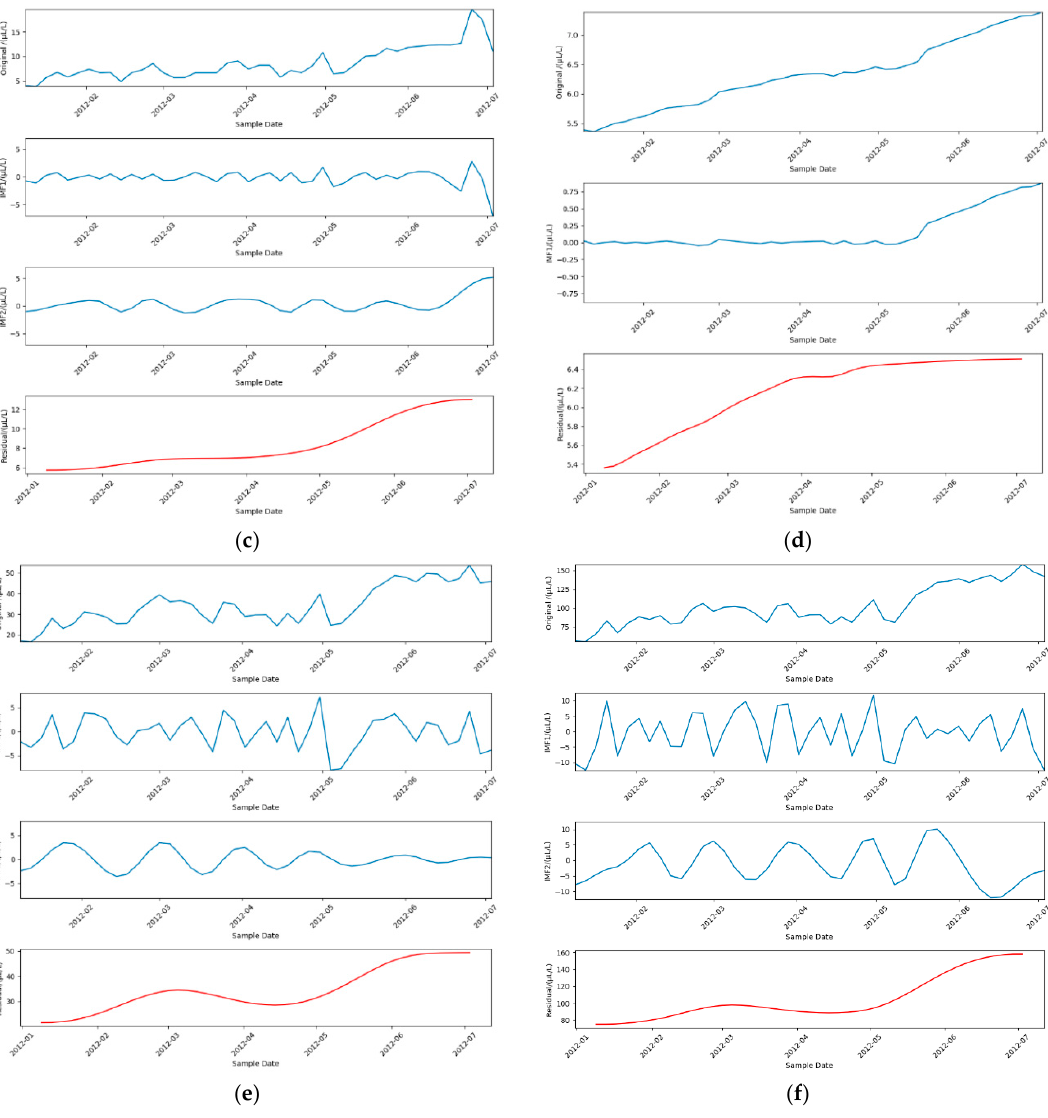
Figure 2. EMD results of the dissolved gas concentration. ( a ) H 2 ; ( b ) CH 4 ; ( c ) C 2 H 6 ; ( d ) C 2 H 2 ; ( e ) C 2 H 4 ; and ( f ) total hydrocarbon.